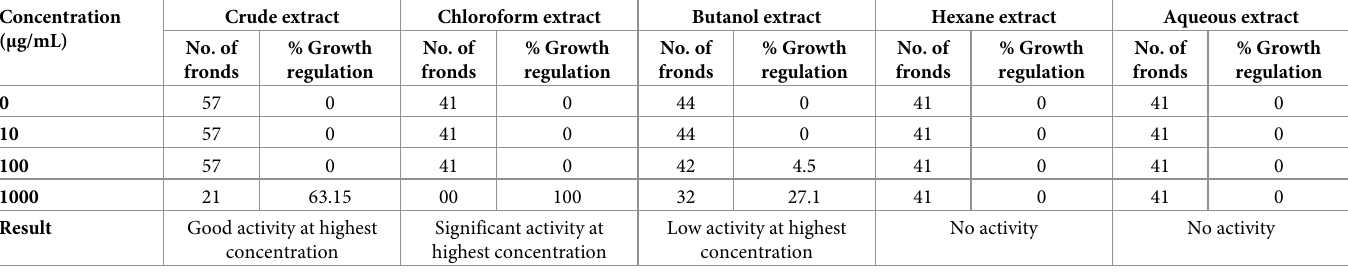
Table 5. In vitro phytotoxic effects of different Euphorbia nivulia Buch.-Ham. extracts against Lemna minor L. Concentration ( μ g/mL)